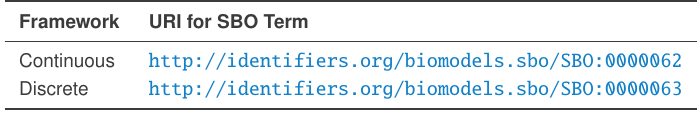
Table 11: SBO terms to specify the framework property of a Model